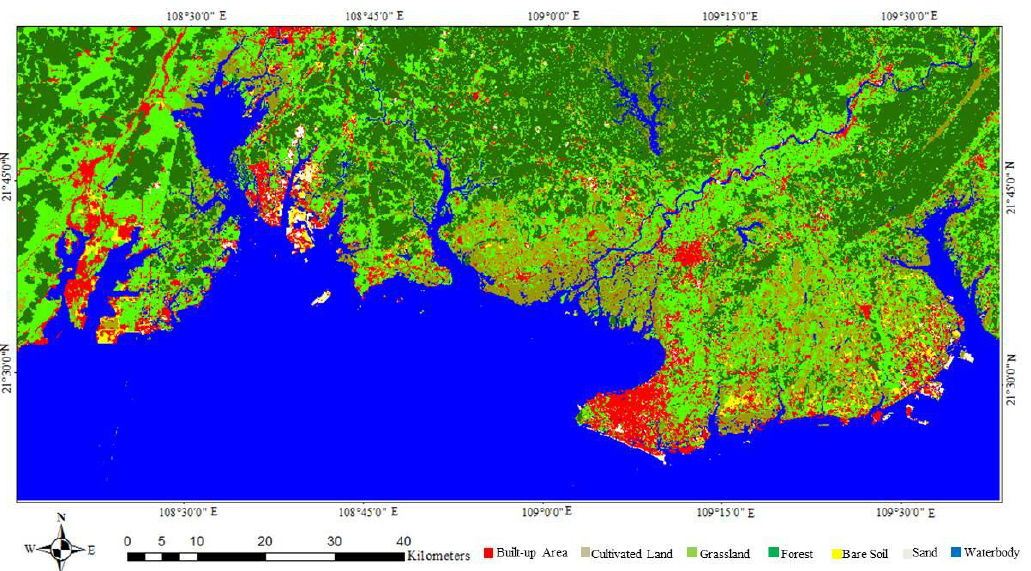
Figure 4. Extraction results of land cover for Beibuwan Gulf in